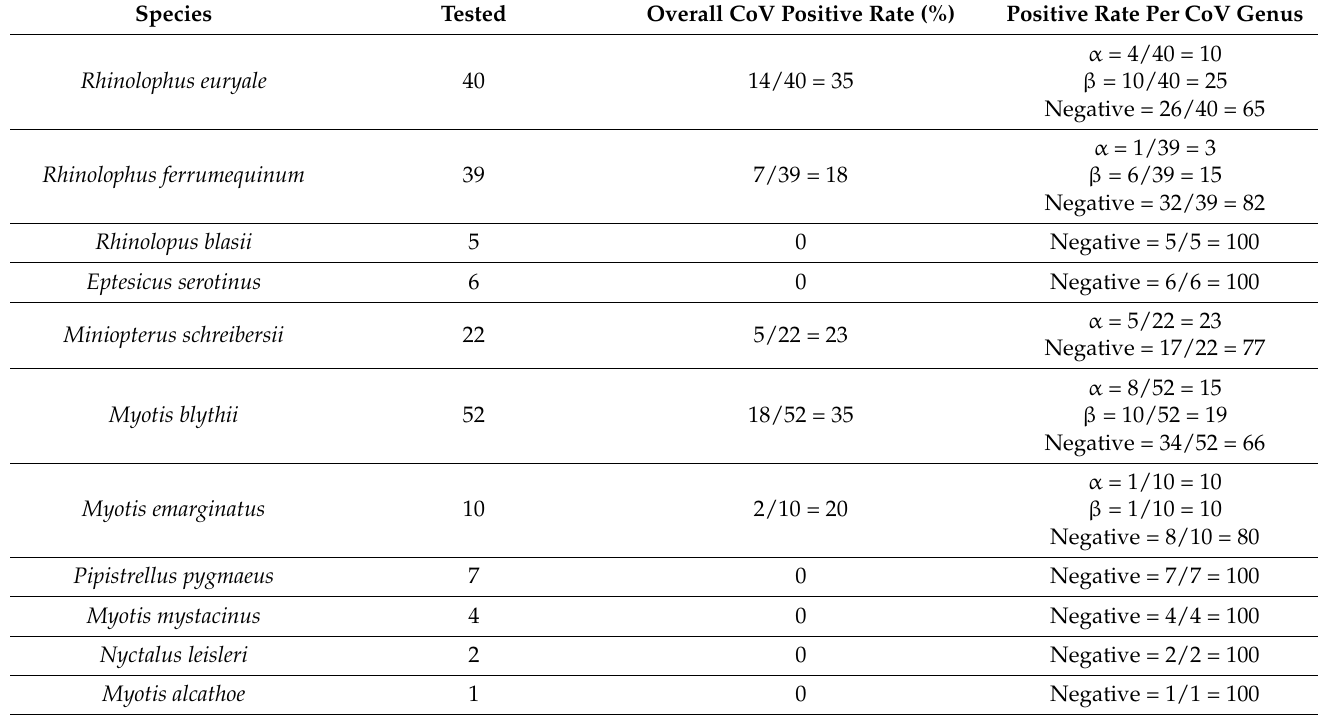
Table 2. Overall and per genus coronavirus positive rate across bat species